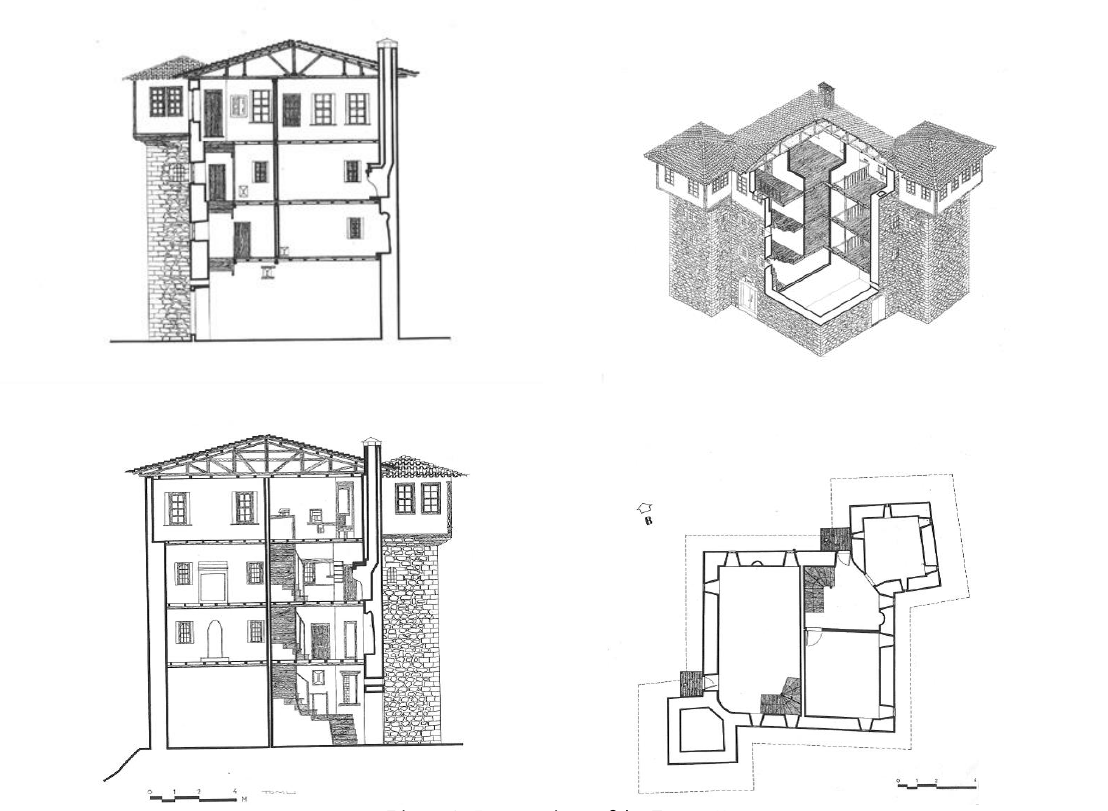
Figure 3: Intersections of the Tower House